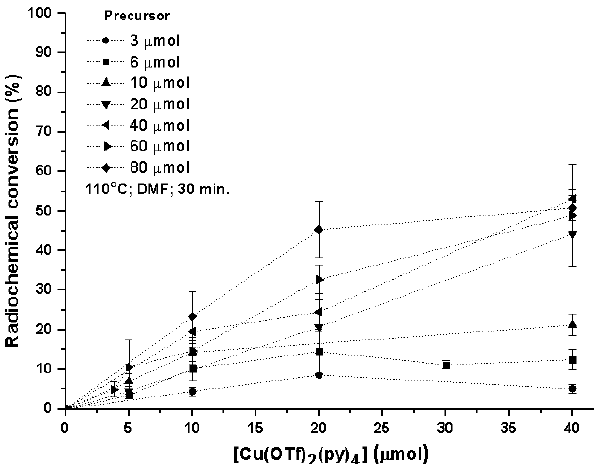
Figure 2. Impact of the Cu catalyst and precursor in the radiochemical conversion (RCC) of 4-